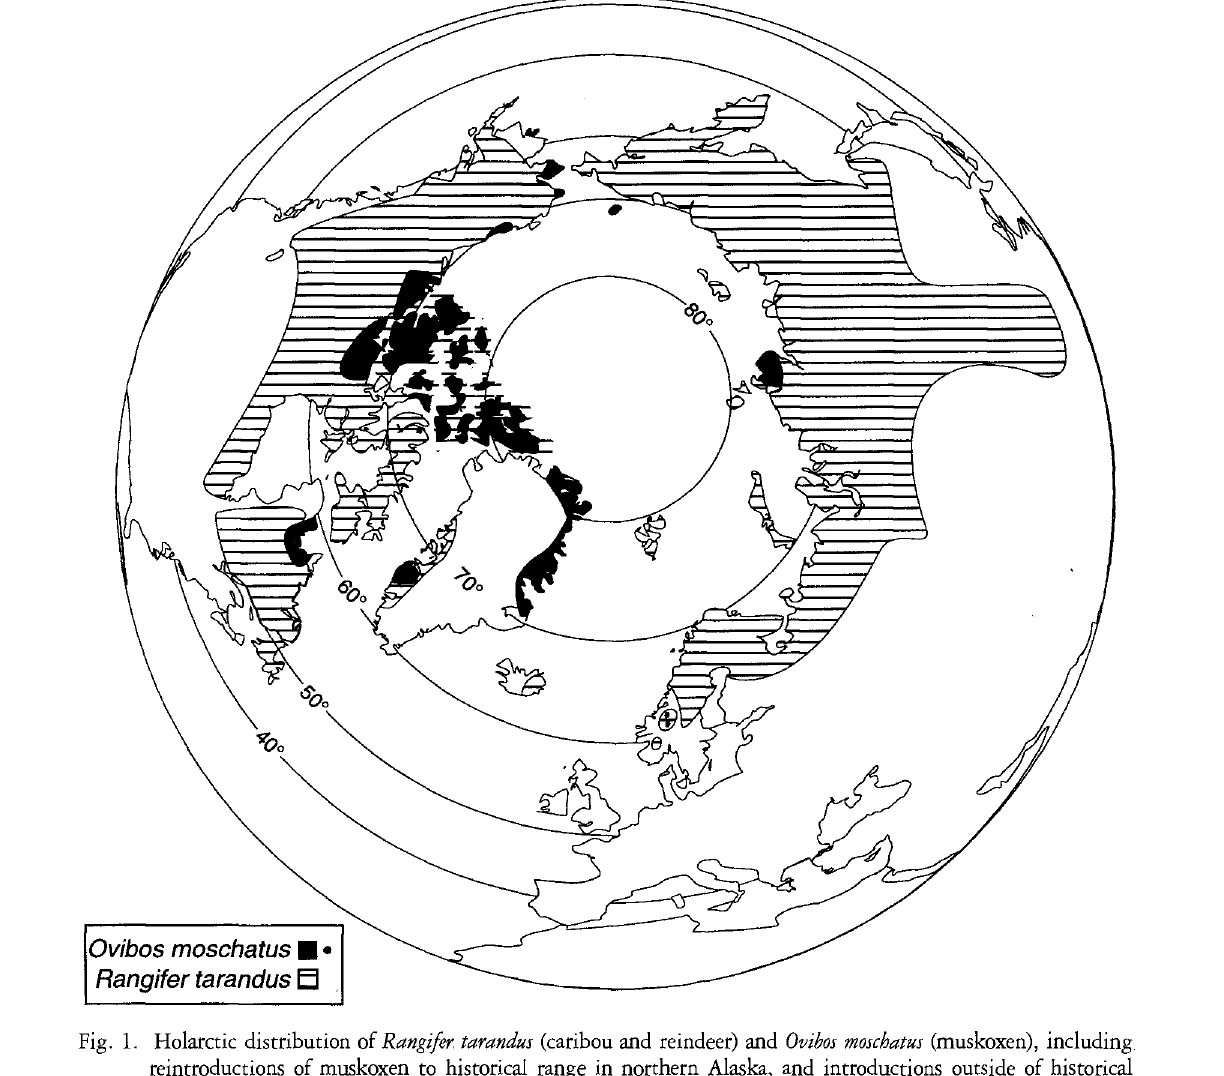
Fig. 1. Holarctic distribution of Rangifer tarandus (caribou and reindeer) and Ovibos moschatus (muskoxen), including reintroductions of muskoxen to historical range in northern Alaska, and introductions outside of historical range in western Alaska, Quebec-Labrador, western Greenland, Norway, Sweden, and the Taimyr Peninsula and Wrangel Island of